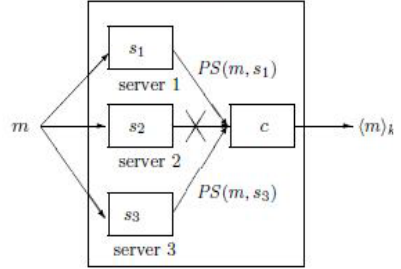
Figure (2): Threshold signature K/k